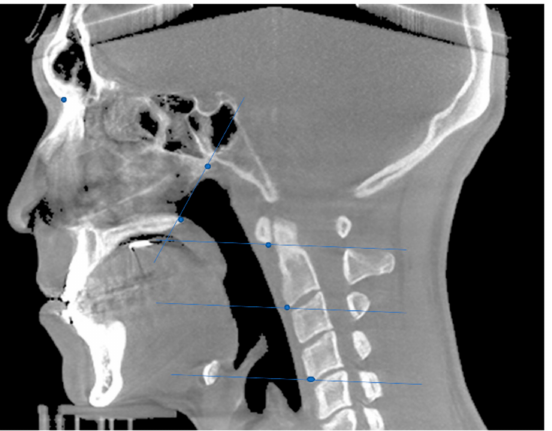
Figure 1. Coordinate and plane determination in the midsagittal plane of the cone-beam computed tomography (CBCT)